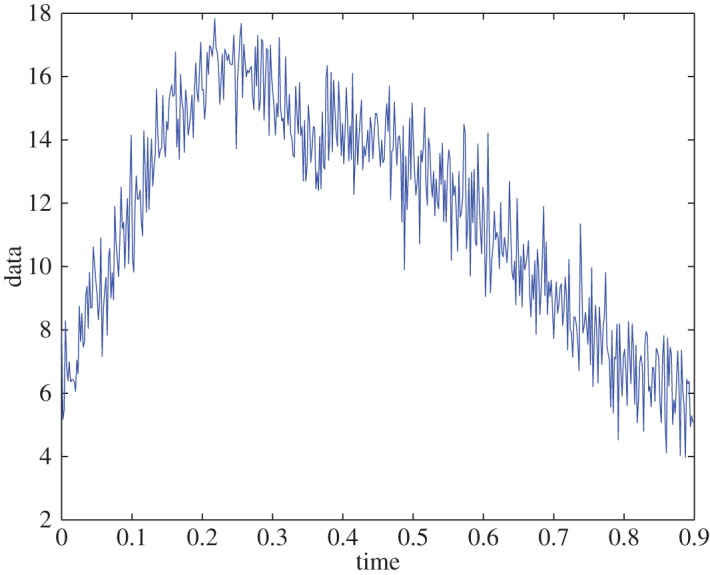
Original noisy data.